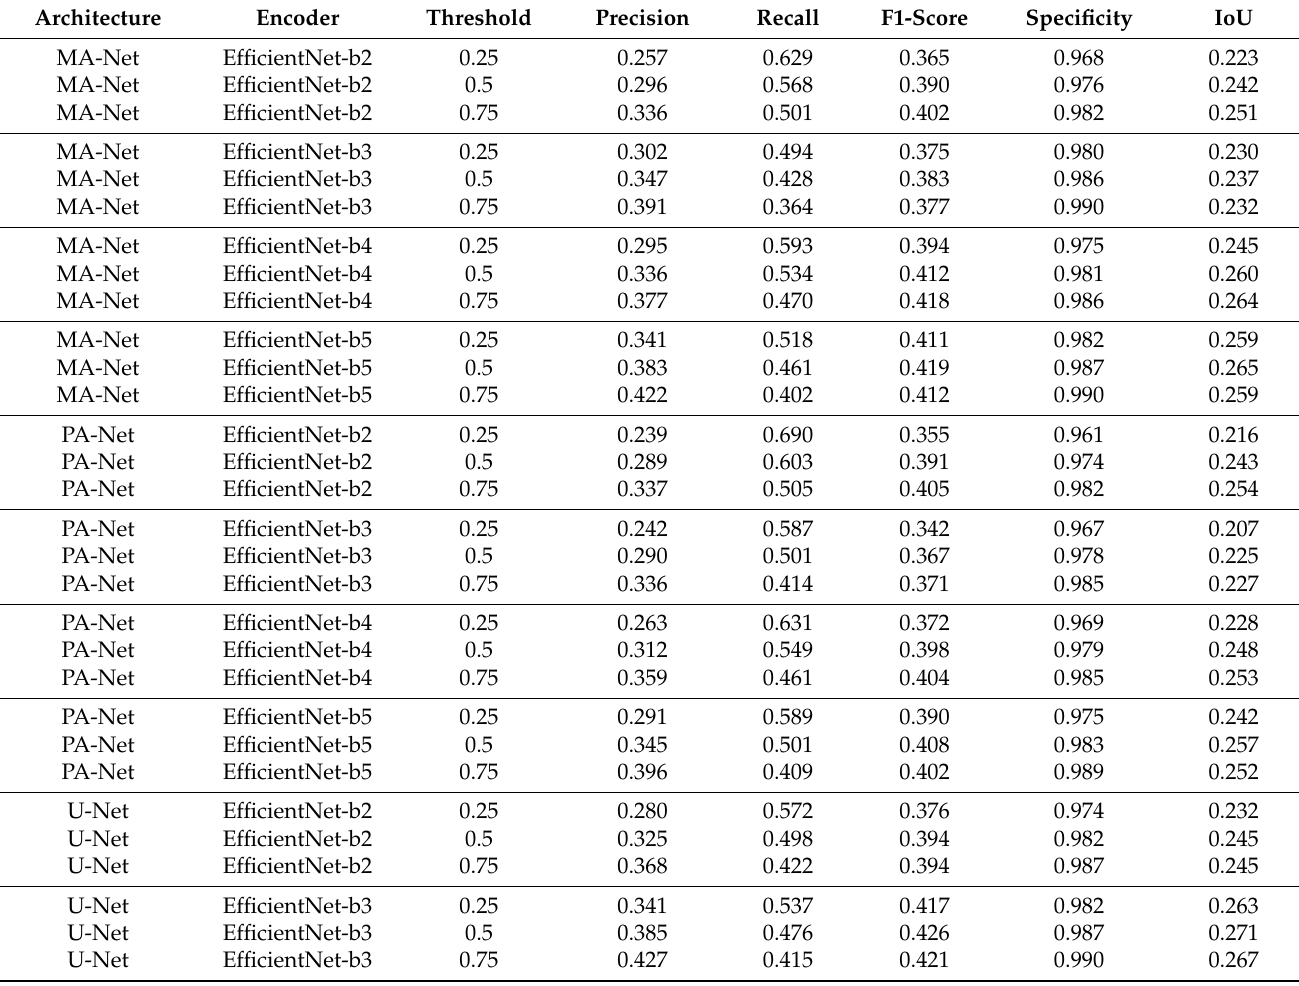
Table A1. The table shows the metrics 1 for all the encoder and architecture combinations trained